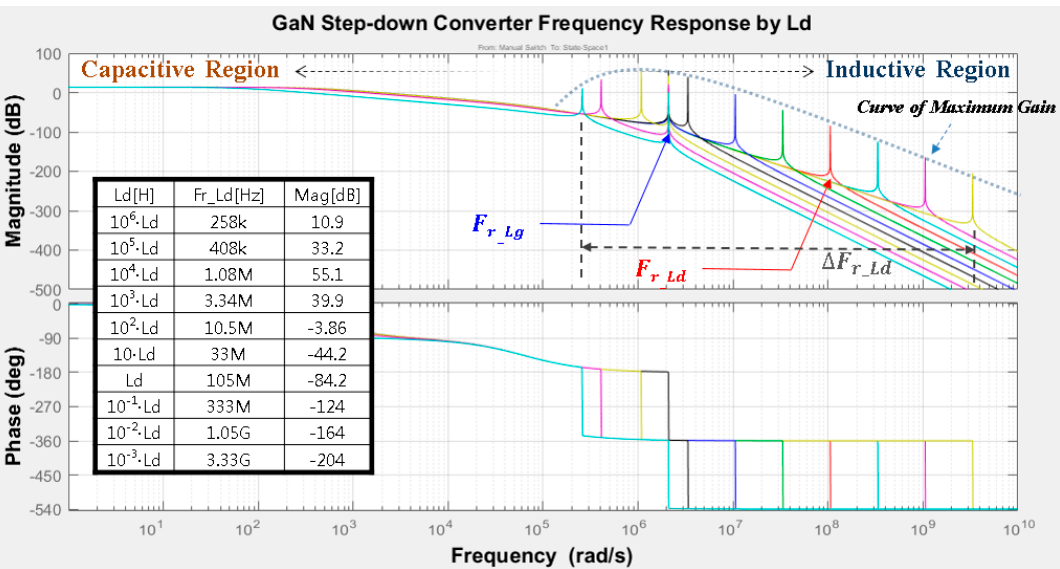
Figure 8. The system frequency response with variation of drain-inductance ( L d ).